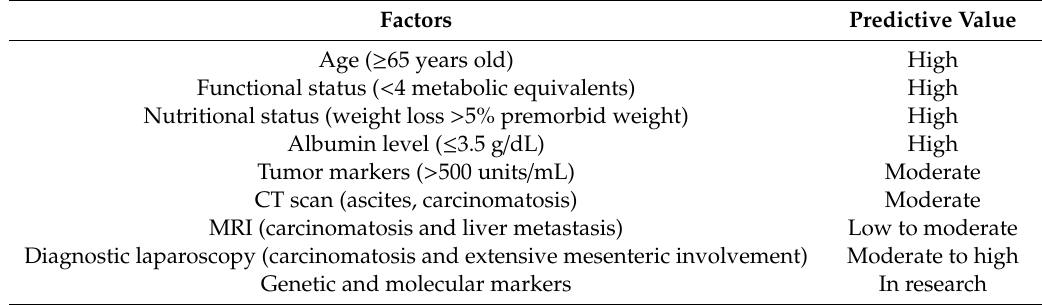
Table 1. Preoperative assessment. CT: computed tomography. MRI: magnetic resonance